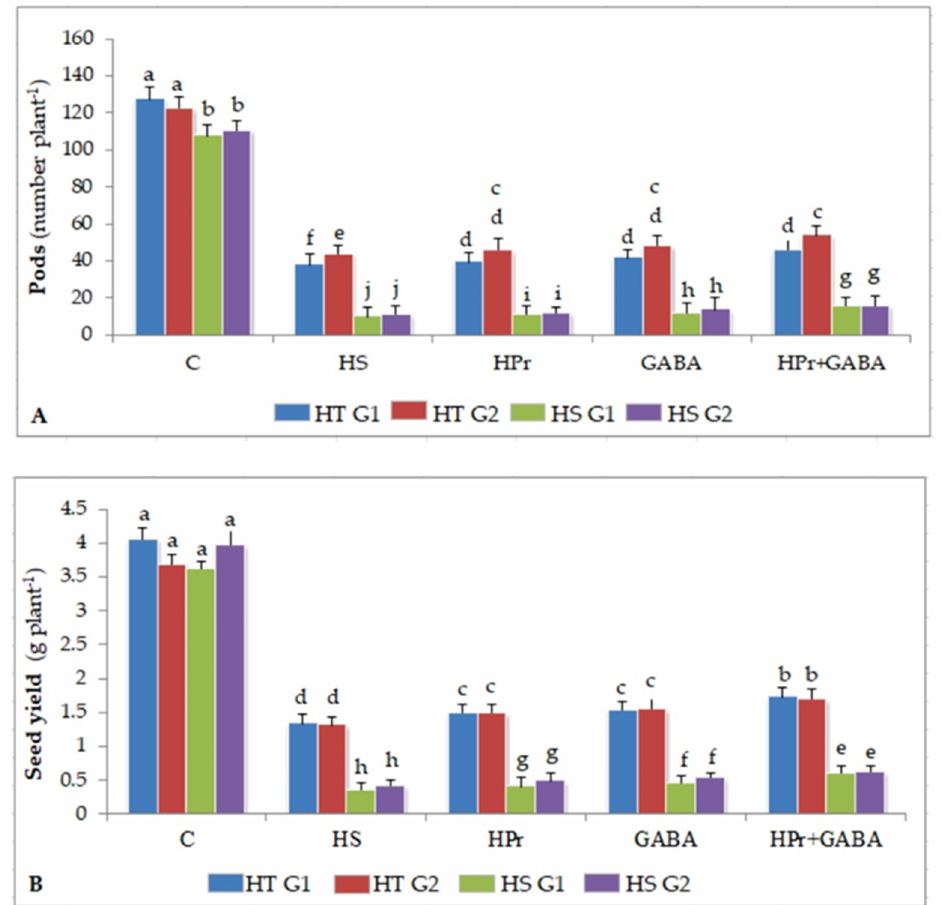
Figure 9. Effect of heat priming (HPr) and γ -amino butyric acid (GABA), applied individually or in combination (HPr+GABA) on pod number ( A ) and seed yield/plant ( B ) in heat-tolerant (HT; G1: IG2507; G2: IG3263) and heat-sensitive (HS; G1: IG2821; G2: IG2849) genotypes in heat-stressed (HS) lentil plants, compared to control ( C ). Vertical bars represent standard errors ( n = 3). Different small letters on the bars indicate significant differences from each other ( p < 0.05). LSD for interaction (genotypes × stages × treatments) ( p < 0.05): pod number: 6.8, seed yield/plant: 0.29.